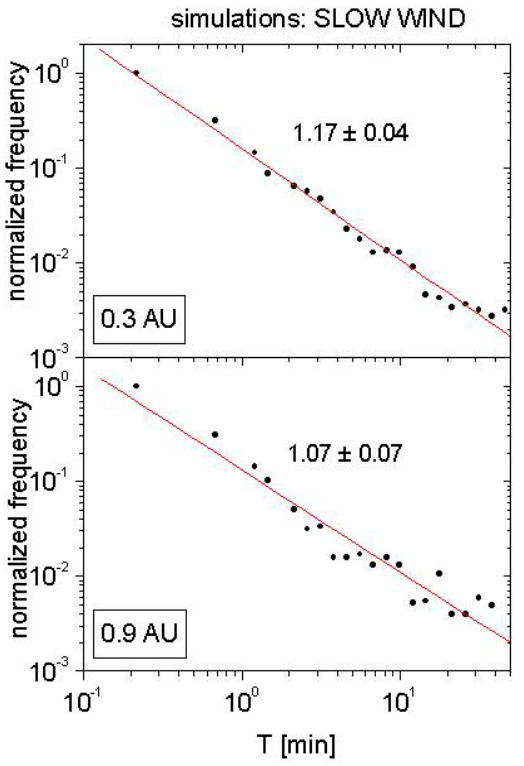
Fig. 7. Slow wind numerical simulation: waiting-time distributions as a function of the radial distance. The points are derived from an average of the histogram over logarithmically, equally spaced intervals and are normalized to the maximum